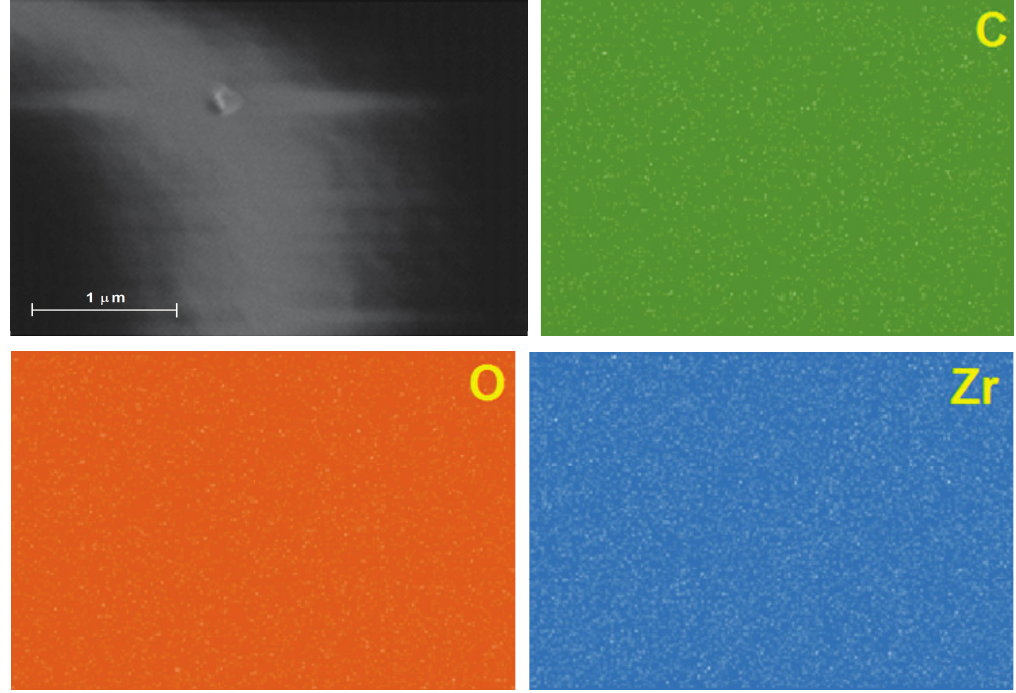
Figure 8. SEM images and EDS mapping images of a ZrO 2 xerogel with the CoTSPc species trapped inside the